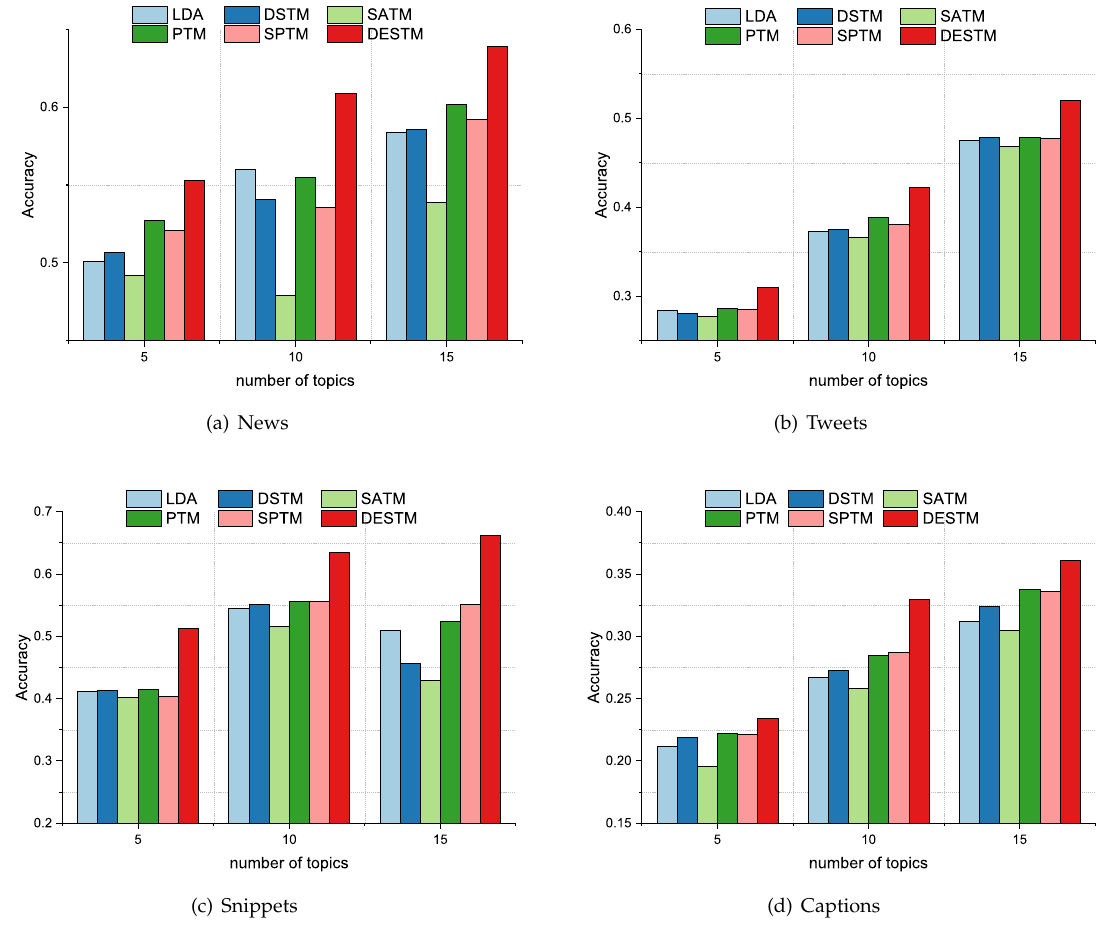
Figure 3. Classification accuracy of all models on 4